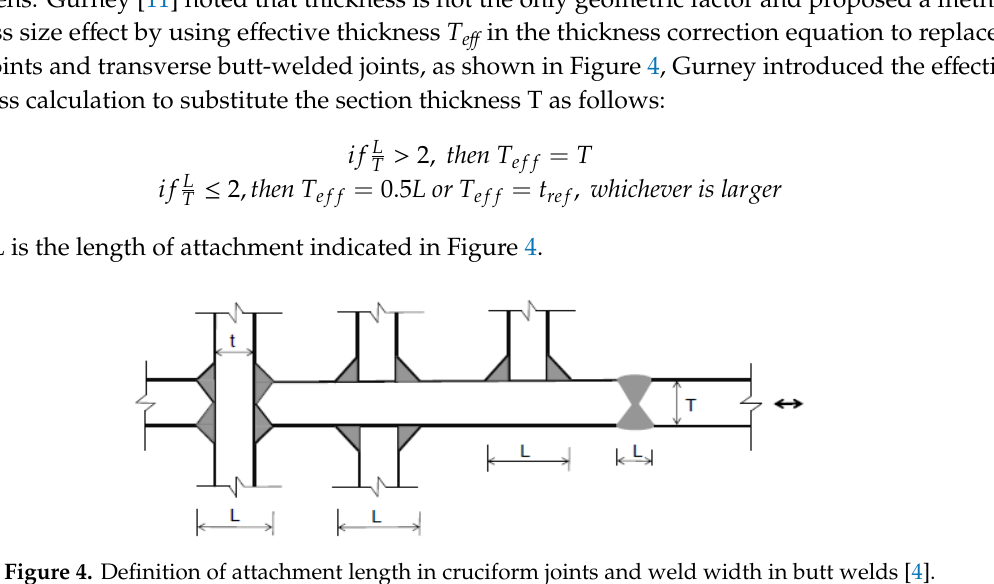
Figure 5. Dimensions for size effect correction